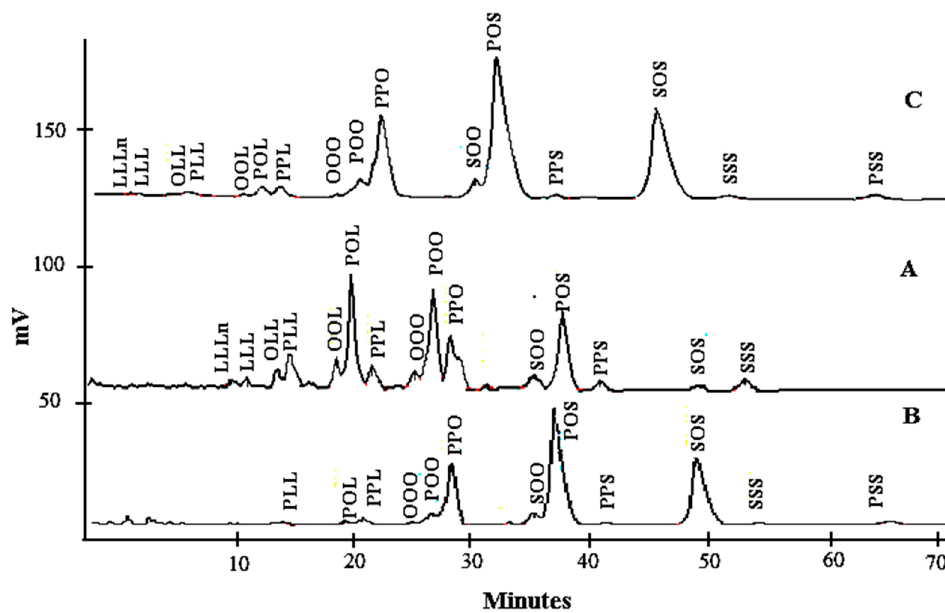
Figure 1. The chromatogram of lard (A), cocoa butter (B), and their admixture (C).